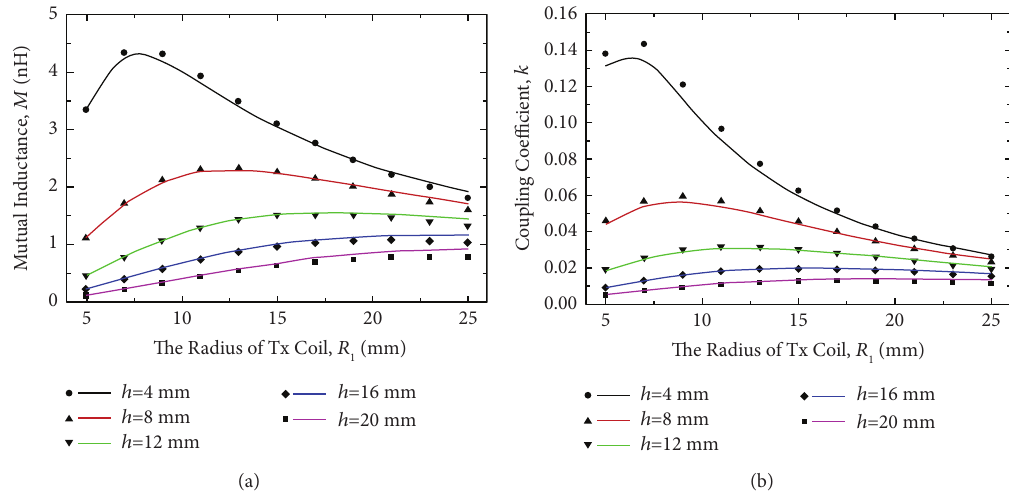
Figure 3: Simulation and analytical results for (a) M of the WPT system and (b) k of the WPT system. The radius of the Tx coil, R from 5 to 25mm, while the spacing between the two coils, h is swept from 4 to 20mm. Symbols and lines represent the simulation and analytical results, respectively. R 2 � 5 mm, r 1 � 0.287mm, r 2 � 0.04mm, and f p � 30MHz.